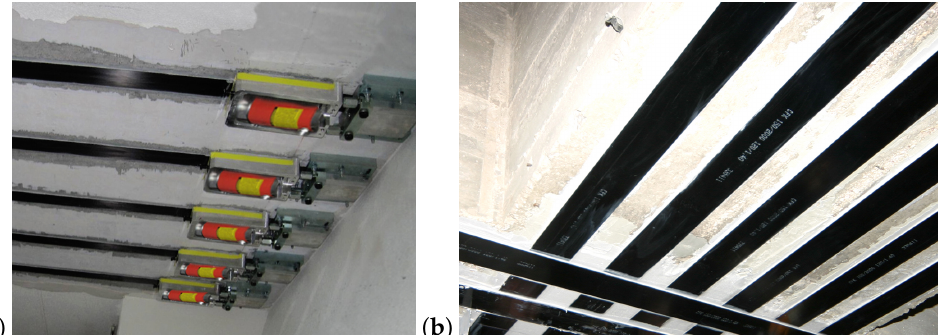
Figure 1. Application of Carbon-Fiber-Reinforced Polymer (CFRP) laminates: ( a ) pre-stress appli- cation on the laminates; ( b ) final application of the laminates (images provided by S&P, Clever Reinforcement Iberica—Materiais de Construçao,